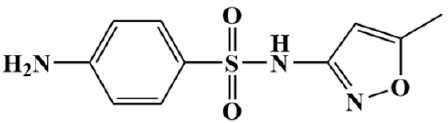
Figure 1. Chemical structure of Sulfamethoxazole.